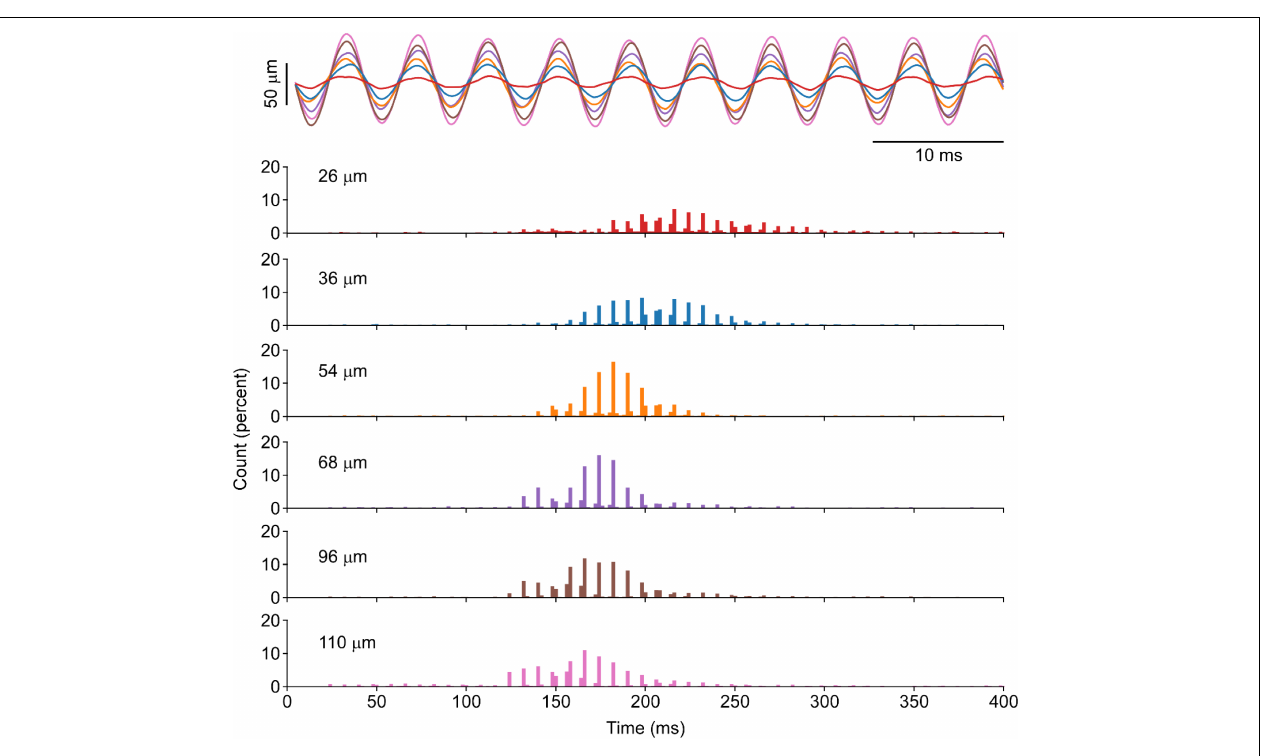
FIGURE 3 | Motor unit response to vibration of different amplitudes in the cat’s soleus. A segment of position recording of vibration excursion overlapped across a range of amplitudes is shown for six different amplitudes at the same vibration frequency in one animal. The corresponding cISI of evoked at each length shown increased vibration amplitude will produce a leftward shift in the ISI, whereas the punctuation remains evident at all vibration